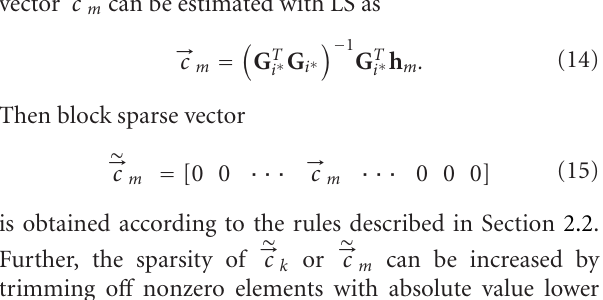
Figure 2: Sparsity of coe ffi cient vector a subspace G i in which h m can be represented with an error level smaller than η . The former best-fit method is implemented in Section 3 for performance